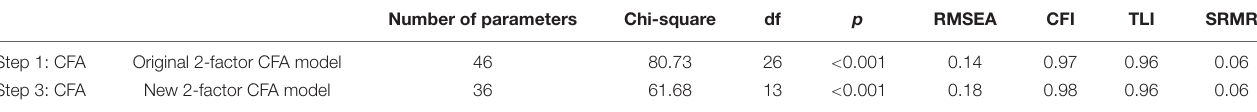
TABLE 4 | Model fit indices for the TSS internal structure validation. Number of parameters Chi-square df